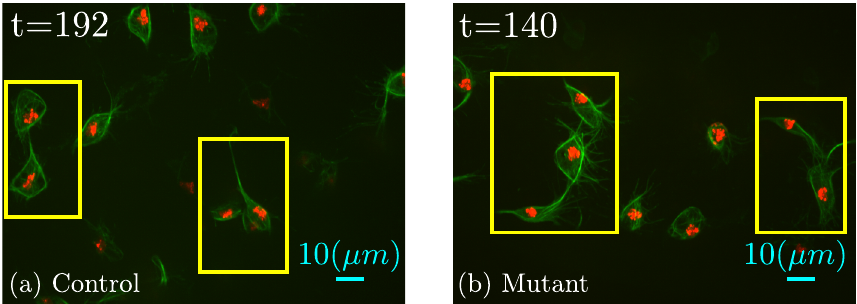
Figure 3. Illustration of a series of clumps in ( a ) control and ( b ) mutant experiments. Both datasets present overlapping events, i.e., clumps , which are highlighted with yellow boxes. It should be noted that although the microtubules are overlapping, the nuclei are still